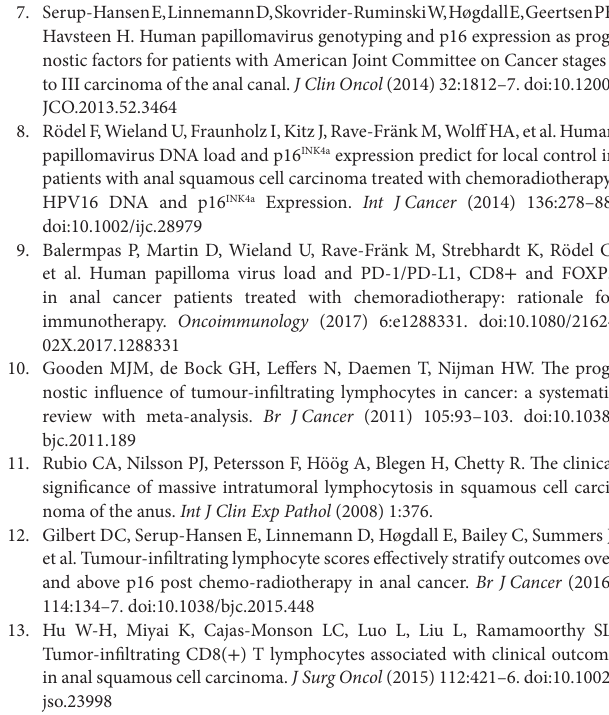
FigUre s1 | Association of pretreatment platelet count with (a) intratumoral and (b) stromal CD8 + T-cells. FigUre s2 | Prognostic impact of WBC on (a) LRC, (b) DMFS, (c) DFS, (D) OS. Patients were dichotomized according to a WBC count ≥ 10 nl -1 . LRC, locoregional control; DMFS, distant-metastasis-free survival; DFS, disease-free survival; OS, overall